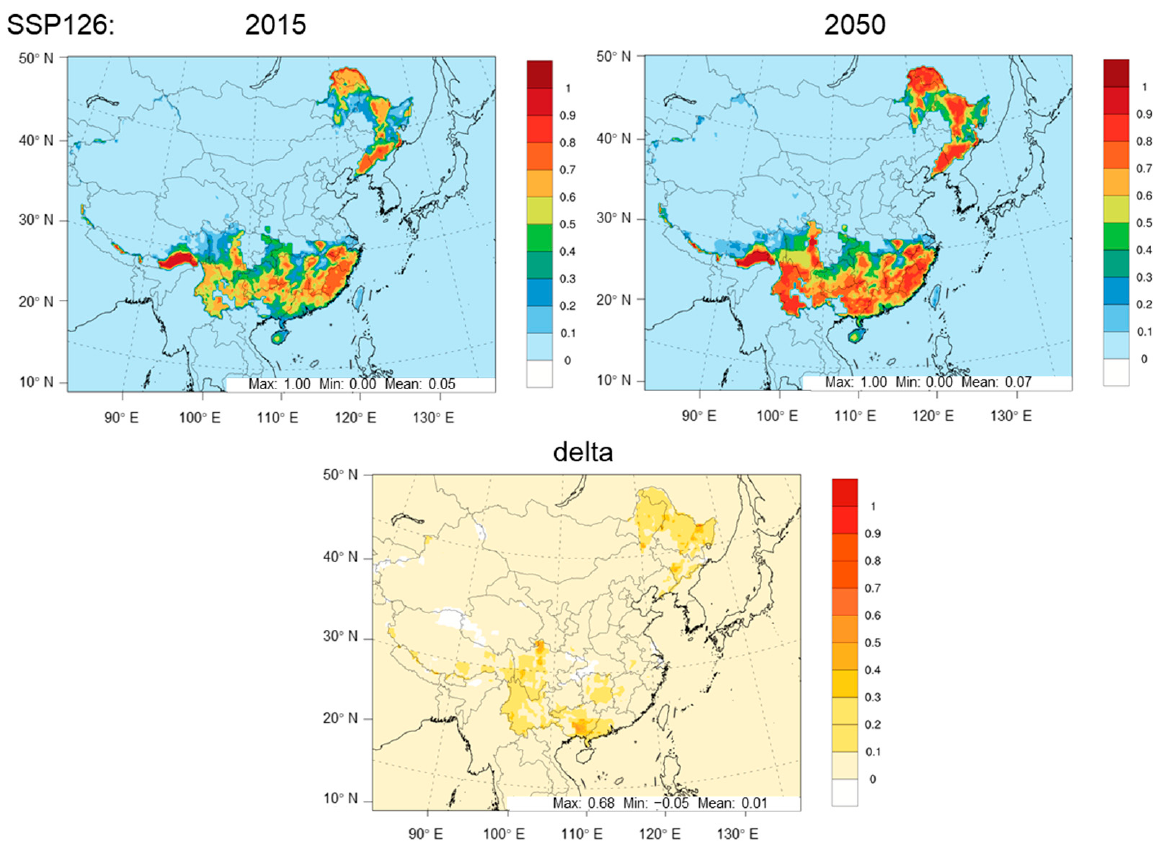
Figure 3. Changes in proportion of land-use type secdf between in 2015 and in 2050. The SSP585 was distinguished by rapid and resource-intensive development that corresponds to material-intensive consumption patterns, as well as technological advances, including agricultural productivity. In the SSP585 scenario, which represented the highest level of emissions, we considered very high levels of fossil fuel use, doubling global food demand, and tripling GHG emissions by 2050. Under the SSP585 scenario, there would be a strong expansion of global cropland into pastures and woodlands, with a global increase of about 300 Mha (20%), a trend that also applied to the downscaling results in China. 3.2. Changes in BVOC Emissions Driven by Land-Use Changes Land-use changes directly affect emissions from terrestrial natural sources. Increased vegetation coverage, for example, results in a significant increase in BVOC emissions. We examined the changes in terrestrial natural source emissions driven by land-use change under SSP scenarios from 2015 to 2050. The findings revealed that, after changing land-use type, BVOC emissions changed significantly, whereas changes in soil-source nitric oxide (NO) and dust emissions were still controlled by meteorology. This is because the land- use change data used in this study primarily concern forests, pastures, crops, and other vegetation-related types but do not include the prediction of refined soil types, making BVOC the most sensitive to such changes. Figure 4 depicts the monthly variations in soil-source NO and BVOC emissions in China under various scenarios. The soil-source NO emissions from the five simulation sets showed only three magnitudes that corresponded to their respective input meteorological data, indicating that there were no significant differences between simulations using the same set of meteorological data and different land-use data. BVOC emissions, on the other hand, produced different results. For ex- ample, the magnitudes of ssp126 and ssp126g simulation results using the same set of meteorological data but different land data were not the same. In general, the